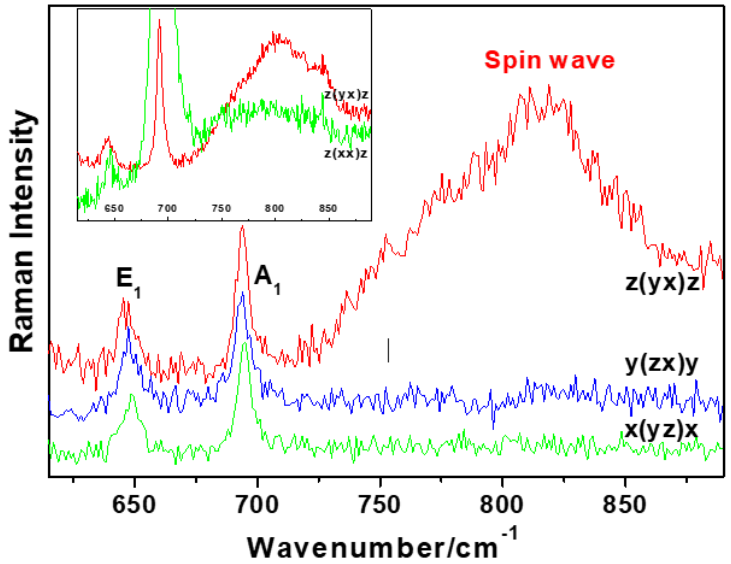
Figure 4. Polarized Raman spectra ofspin wave scattering in hexagonal LuMnO 3 single crystal, which is from Figure 1 of Ref. [89]. The inset is from Figure 1 of Ref. [87].